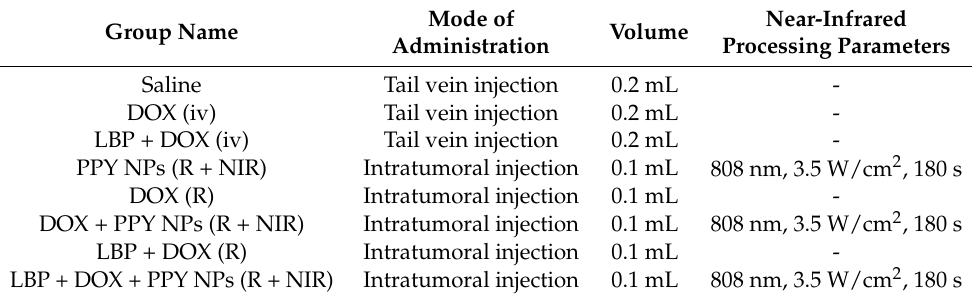
Table 2. In vivo experimental